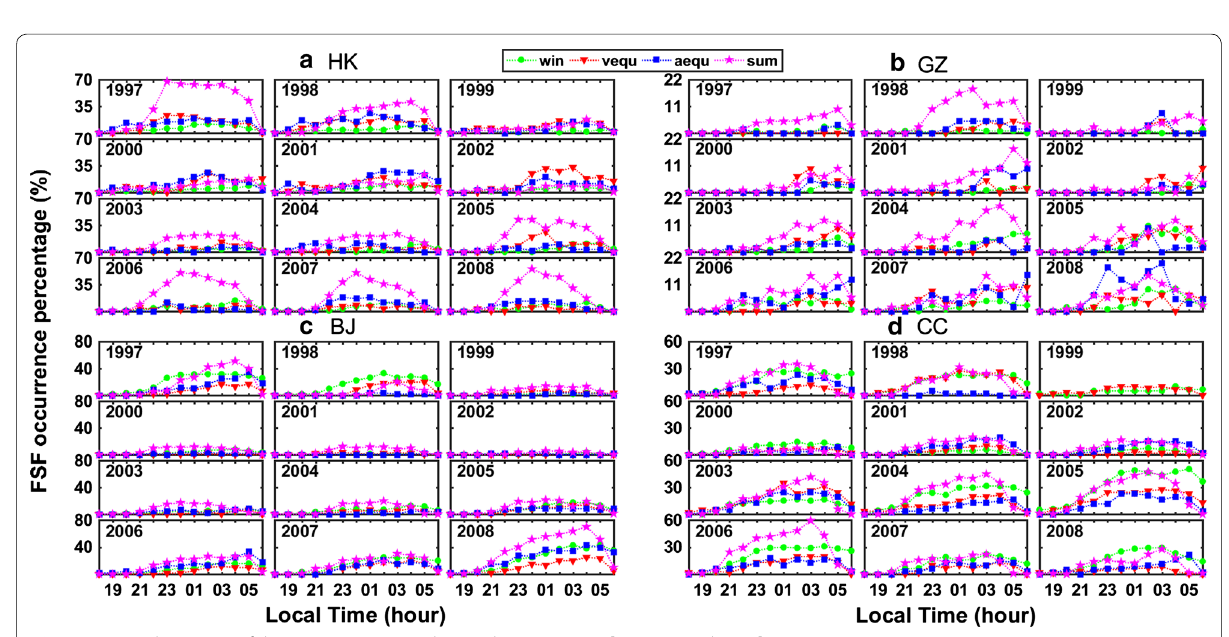
Fig. 5 Seasonal variation of the FSF occurrences observed at HK ( a ), GZ ( b ), BJ ( c ), and CC ( d